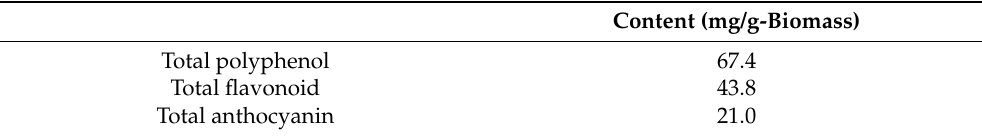
Table 5. Quantification of bioactive compounds in elderberry extract.